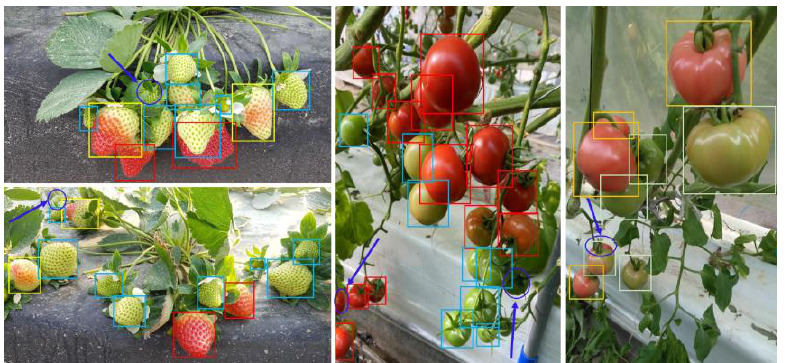
Figure 14. The impact of RTFD model detection on the tomato and strawberry datasets. The blue circles denote locations of inaccurate or missing detections, while the blue arrows act as suggestive indicator symbols. The red, orange/yellow, and light blue corresponded, respectively to mature strawberries, half-mature strawberries, and immature strawberries [49].